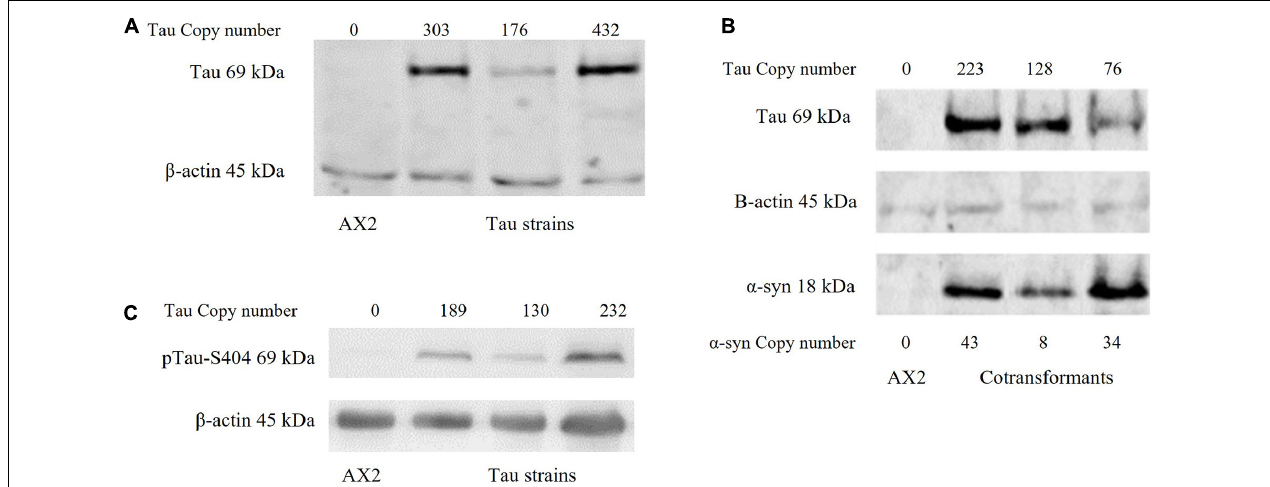
FIGURE 1 | Western blot of strains. (A) Human tau can be expressed in D. discoideum . A western blot showing the expression of the tau protein in D. discoideum . The parental strain AX2 was used as a negative control and β -actin as the loading control. Tau construct copy numbers as estimated by qPCR are indicated at the top of the figure. (B) Tau can be expressed in combination with α -synuclein in D. discoideum . A western blot showing the expression of both tau and α -synuclein in cotransformant strains. The parental strain AX2 was used as a negative control and β -actin as the loading control. Construct copy numbers are displayed for both tau and α -synuclein. Tau runs at 69 kDa while α -synuclein runs at 18 kDa. (C) Tau is phosphorylated in D. discoideum . One of the phosphorylation sites implicated in pathological accumulation and aggregation of the tau protein is S404 (Augustinack et al., 2002). An antibody against phosphorylation at this site was used and indicated that tau can be phosphorylated in D. discoideum . Construct copy numbers are displayed at the top of each lane. β -actin was used as the loading control and the parental strain AX2 as the negative